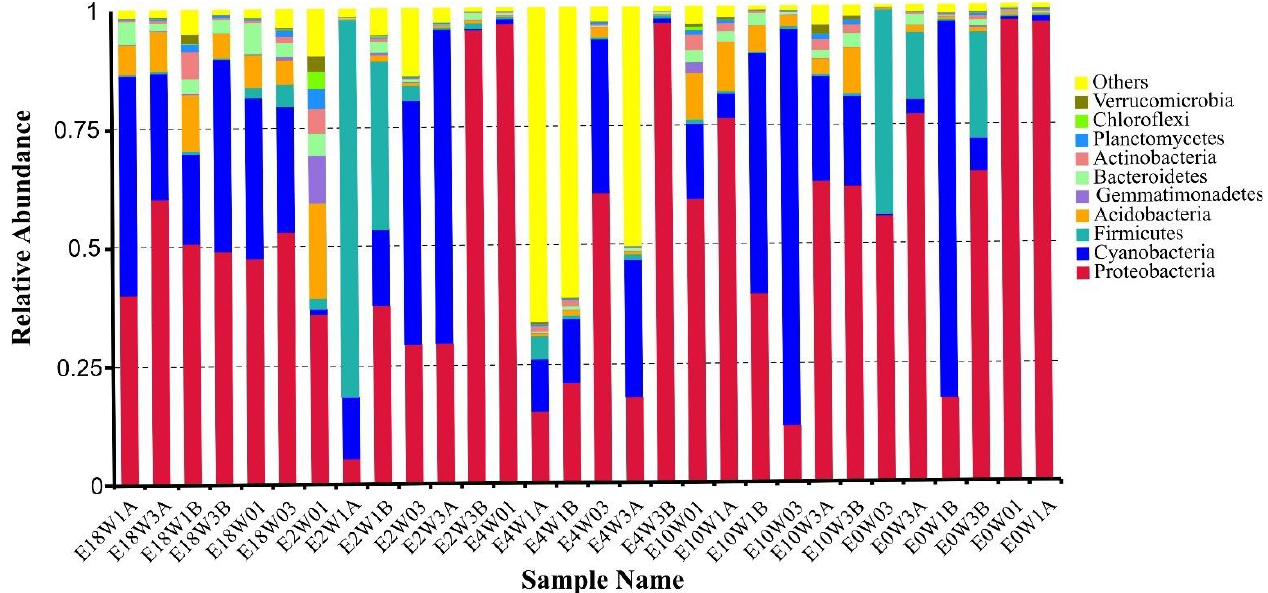
Figure 3. The relative abundance of top 10 phyla of endophytes detected from S. palustre in the Erxianyan peatland.